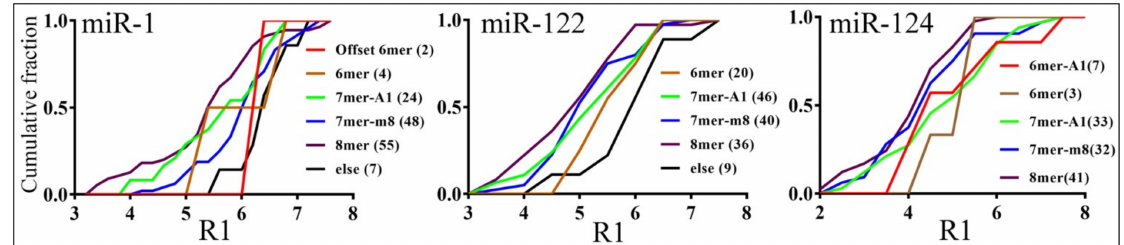
Figure 6. E ff ects of seed types on the degrees of reporter inhibition by miRNAs. X -axes show the R1 values, and y -axes the cumulative fraction. Color lines represent di ff erent seed types in the confirmed, single MRE-containing targets, with each sample size in parentheses. Seed types were categorized according to Bartel [2], and “else” contained targets not belonging to all the other